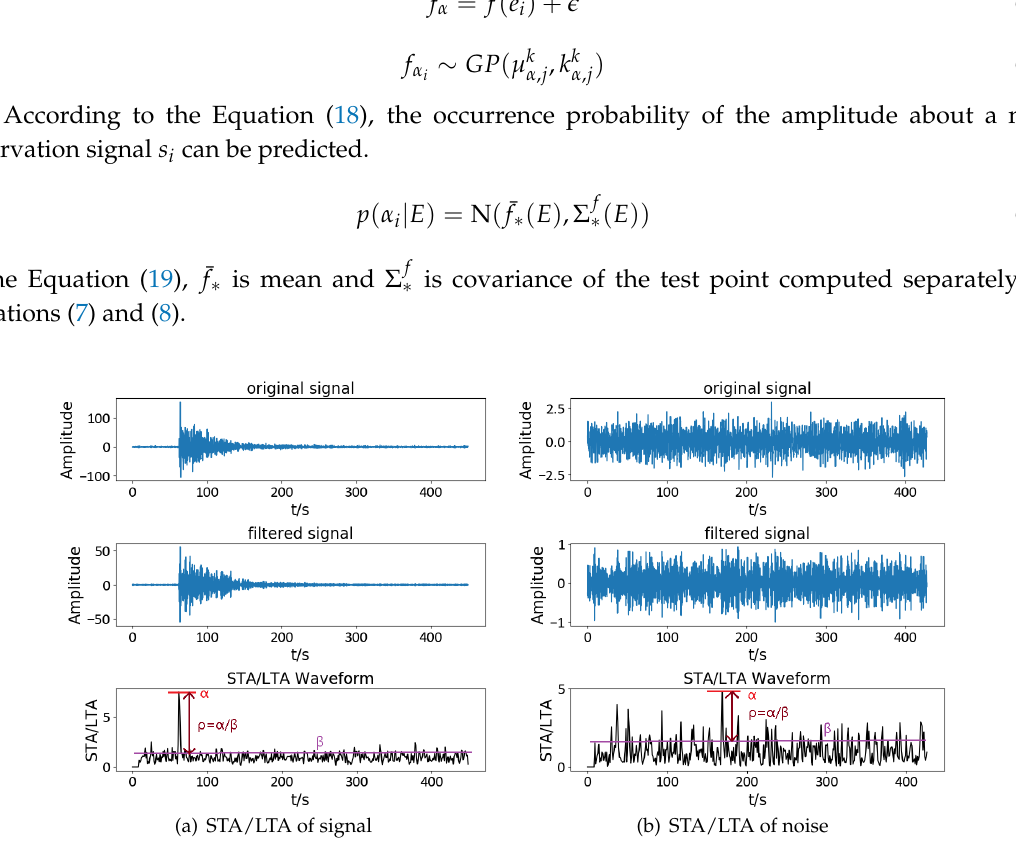
Figure 1. The signal and noise detected by short-term and long-term power averages (STA/LTA). The subgraph ( a ) shows the original signal, filtered signal, and the STA/LTA trace from top to bottom. Correspondingly, the subgraph ( b ) is the detection image of